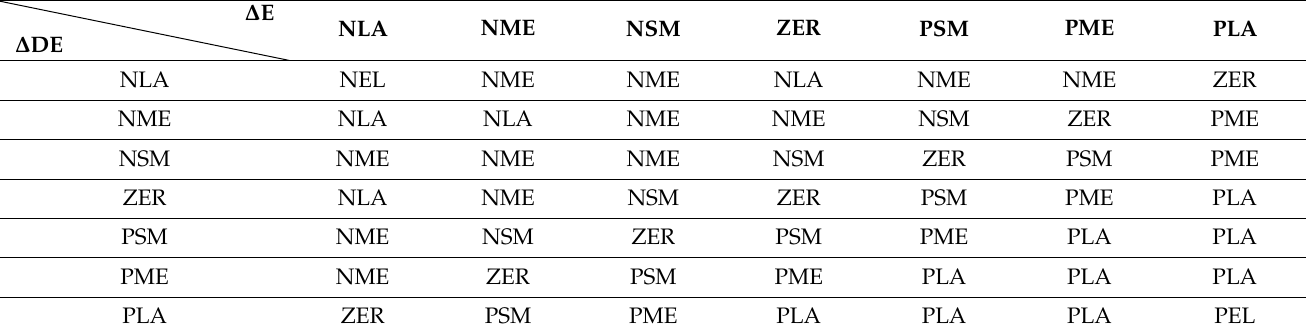
Table 4. Fuzzy rule of error (ΔE) and change in error (ΔDE).